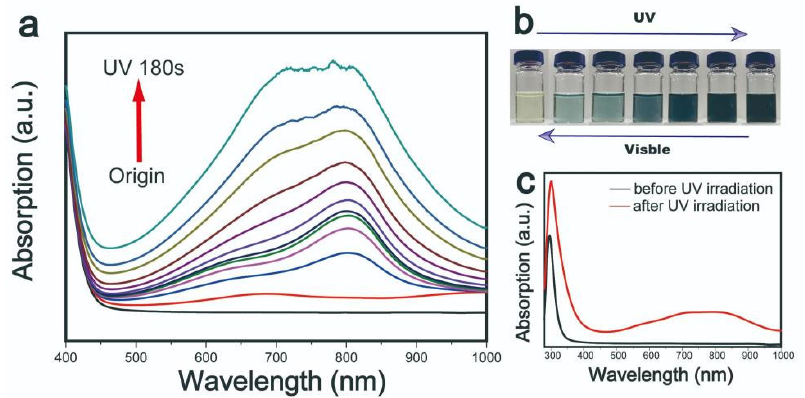
Figure 1. ( a ) The absorption spectra and ( b ) photos of MoO 3-x nanostructures irradiated by ultraviolet light for 180 s. ( c ) The absorption spectra of MoO 3-x nanostructures in the range of UV-Vis light.